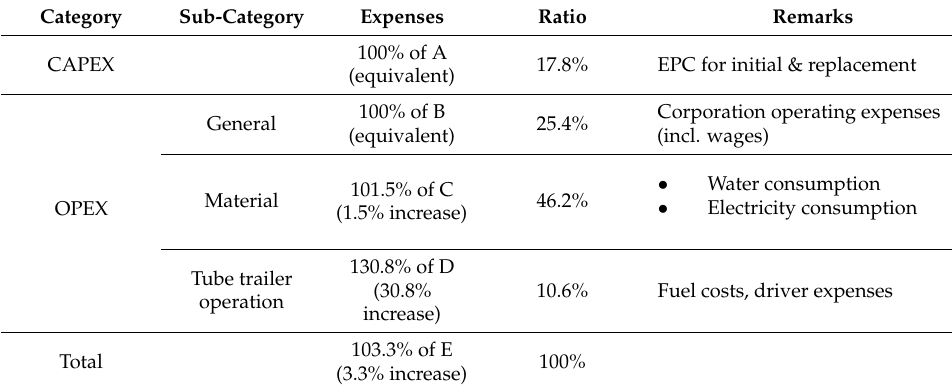
Table 33. Estimation of whole expenses and breakdown (Scenario V).